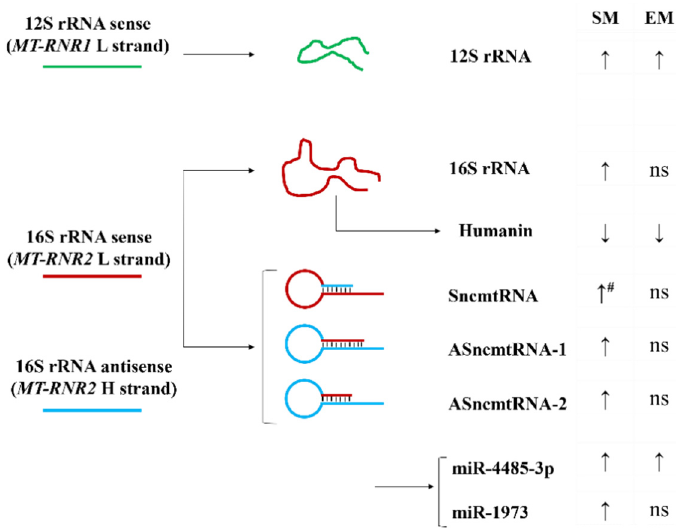
Figure 6. Model of MT-RNR2 derived transcripts and their expression in ATII cells. Increased ( ↑ ) and decreased ( ↓ ) RNA or protein expression in ATII cells obtained from smokers (SM) and emphysema patients (EM) compared to nonsmokers is shown (#—significantly increased expression compared to EM; ns: non-significant).